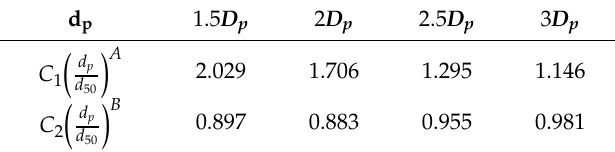
(cid:18) (cid:19) A (cid:18) (cid:19) B d p d p (cid:2885) (cid:3003) and C 2 at various distance of (cid:2914) (cid:3174) (cid:3031) (cid:3291) d 50 d 50 (cid:4673) (cid:4673) and 𝐶 (cid:2870) (cid:4672) at various distance of twin-propeller (cid:2914) (cid:3121)(cid:3116) (cid:3031) (cid:3121)(cid:3116)